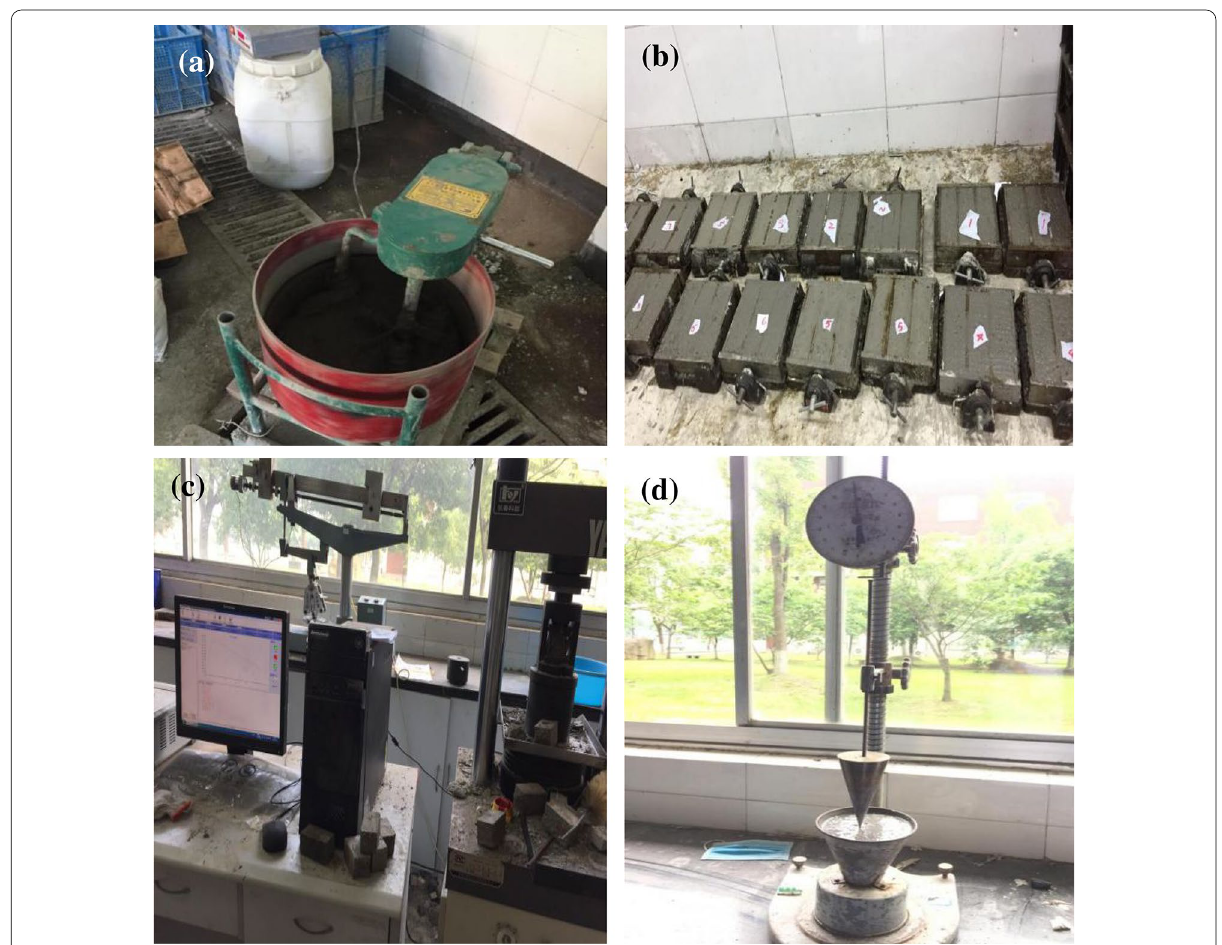
Fig. 1 a Mortar mixing. b Mortar molding. c Determination of compressive strength of mortar. d Determination of mortar consistency value.